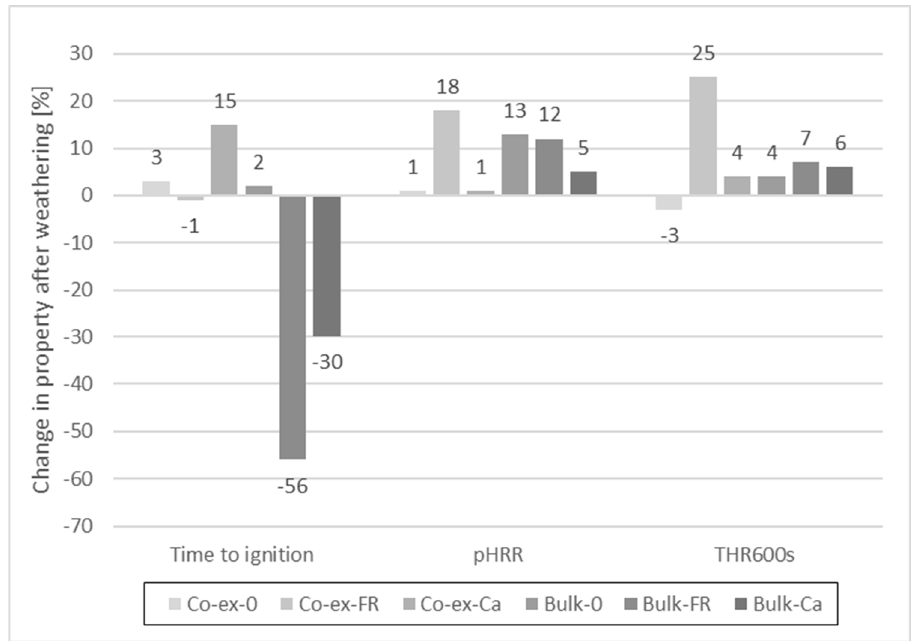
Figure 19. Change in time to ignition, peak heat release rate, and total heat release after 600s in extruded profiles with fire-retardant (FR CROS 490) or calcium carbonate (Ca) or without any filler (0), after artificial weathering for 28 days. FR CROS 490 or Ca were added either in the co-extruded layer or in the bulk of the profiles.